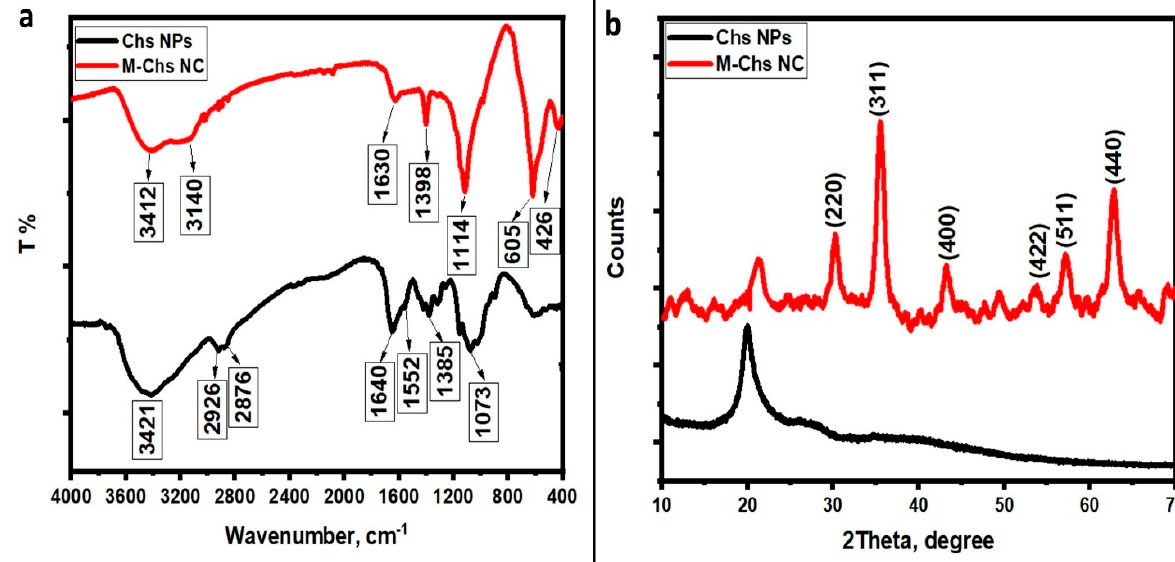
Figure 3. FTIR spectra ( a ) and ( b ) XRD spectra of the extracted Chs NPs and M-Chs